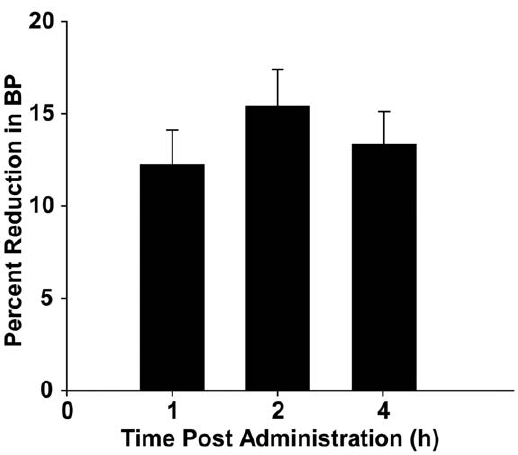
Figure 8. MN10021 lowers blood pressure in SHR rats. Three SHR rats were orally-dosed (by gavage) with MN10021 (100 mg/kg) prepared in 2% Tween 80/distilled water. Systolic blood pressure (BP) measurements were made using a tail-cuff manometer at 0, 1, 2, and 4 h. L-methyldopa (100 mg/kg) was used as a positive control. The percent reduction in BP is calculated based on the 0 h value and is expressed as a mean 6 SE. The experiment shown is representative of two separate experiments.